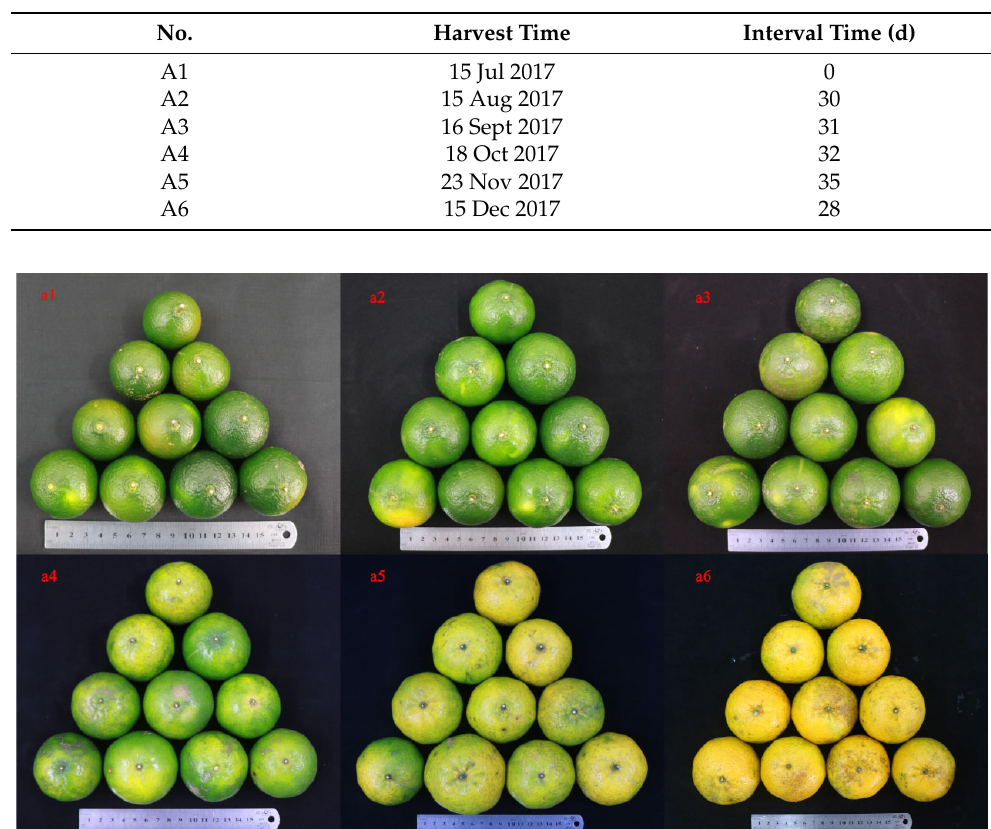
Table 7. Information about PCR samples.